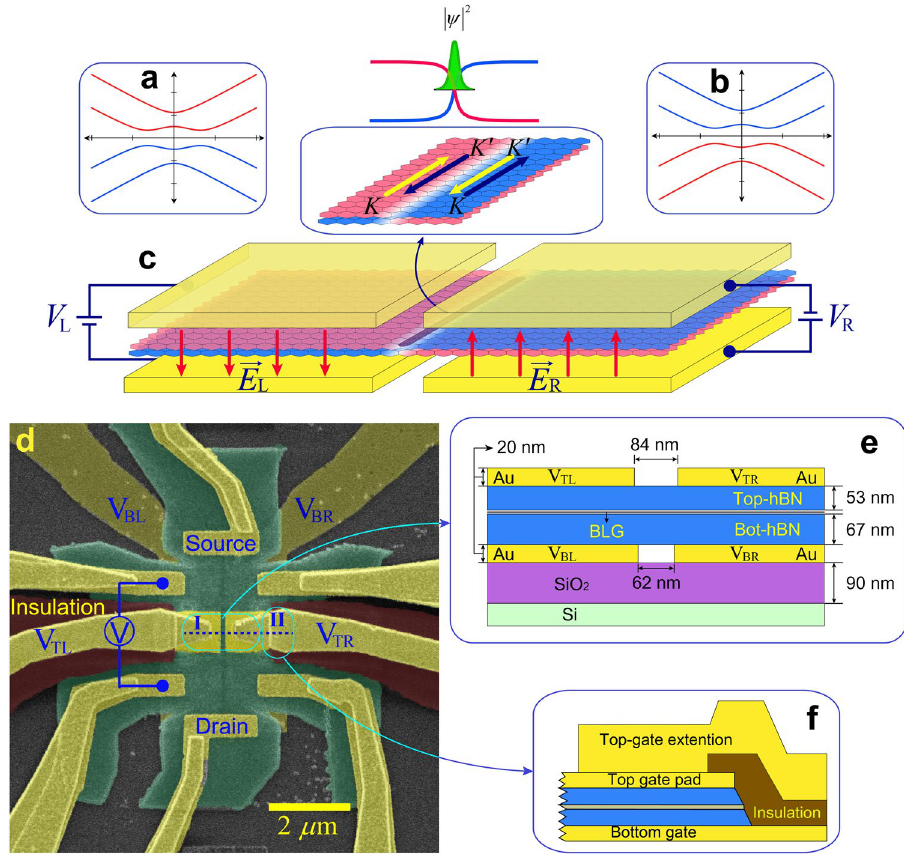
Figure 1. Topological zero-energy mode in bilayer graphene. ( a , b ) Gapped band structures of BLG corresponding to the ( a ) left and ( b ) right half. ( c ) Schematic illustration of the topological zero-energy mode in BLG. Different colours in a and b indicate opposite chiralities. The schematic highlighted view in c illustrates the electric current direction of each valley-momentum-locked zero-energy mode at the boundary between two oppositely dual-gated regions in BLG. ( d ) False-coloured scanning electron microscopy (SEM) image of the four-gated device. ( e , f ) Cross-sectional view along the dotted line in region I and II in d , respectively (see Method and Supplementary Fig. 7 for